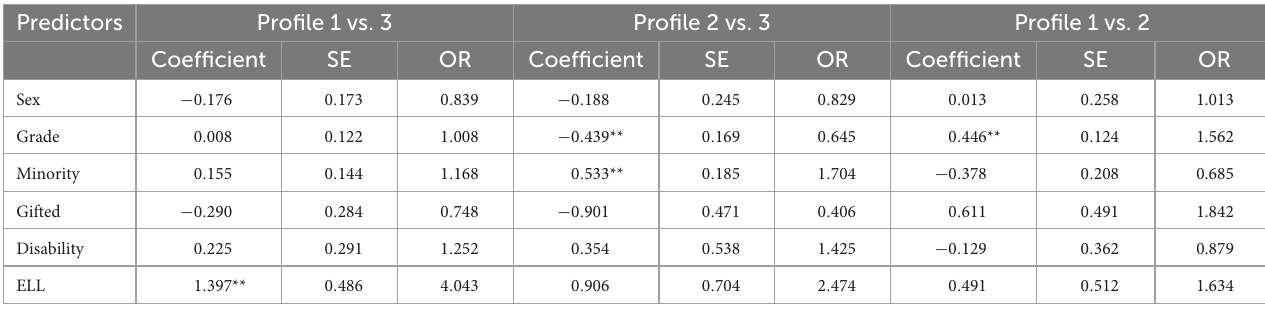
TABLE 8 Predictor coefficients and odds ratios for demographic variables.